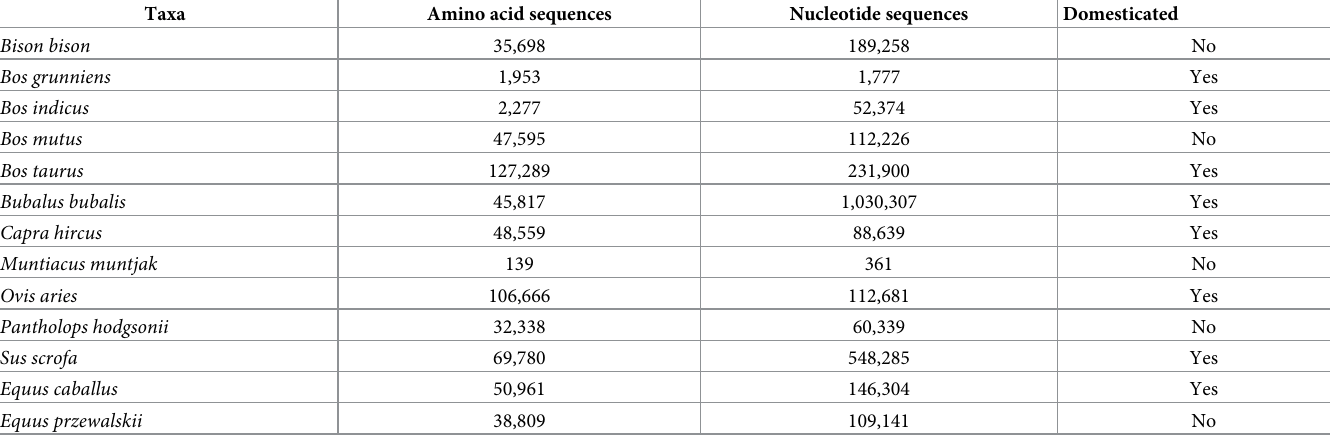
Table 1. The thirteen taxa chosen for this study and respective data.